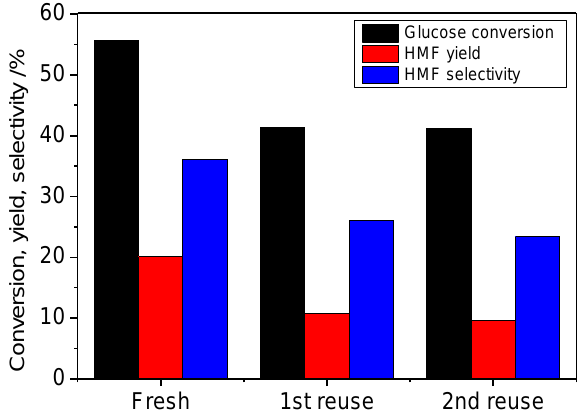
Figure 8. Reuse of HNbWO 6 aggregated nanosheets. Reaction conditions : glucose (50 mg), catalyst (50 mg), water (1.5 mL), 413 K, 3 h.